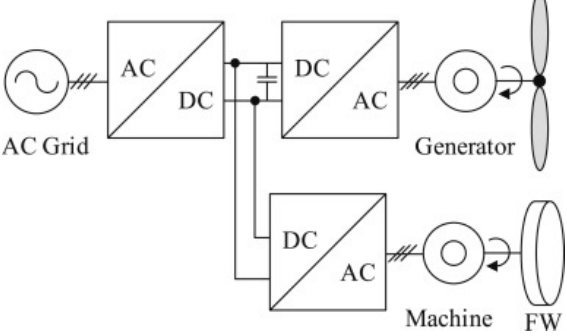
Figure 6. Back-to-back (BTB) plus DC-AC converter connected in DC-link. Reprint with permission [54]; Copyright 2006, IEEE.